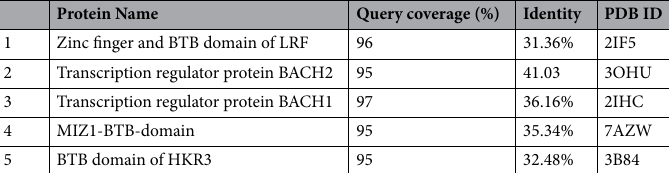
Table 4. The results of top five similar structures to BCL6 BTB